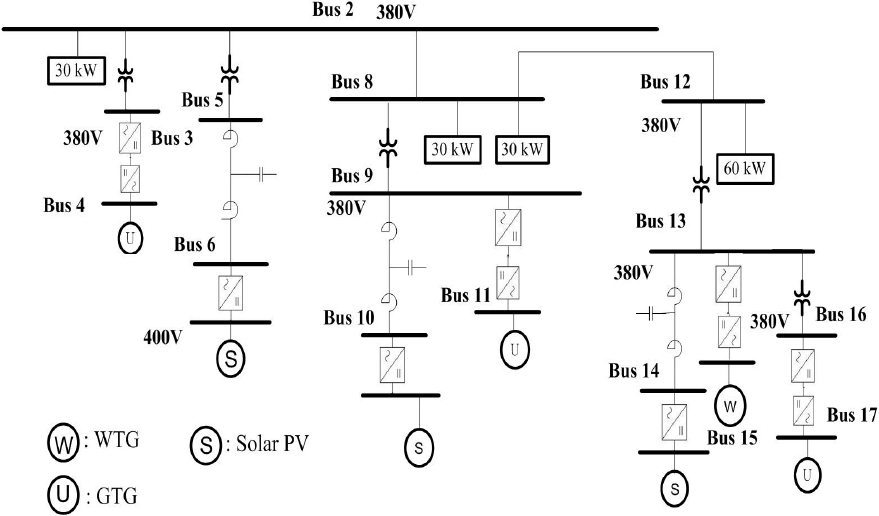
Figure 3. One-line diagram of the studied microgrid. Table 1. Failure rate (occ./year) and annual outage duration (h/year).